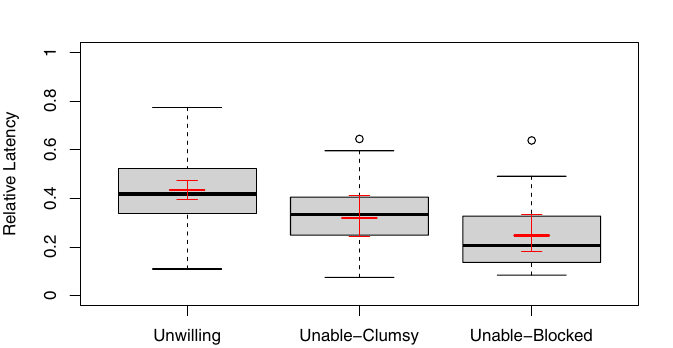
Figure 2. Relative latencies of going around the partition. Boxplots depict 25 th and 75 th percentiles and circles depict outliers. The fitted model is depicted in red. Error bars of the model show the 95% confidence